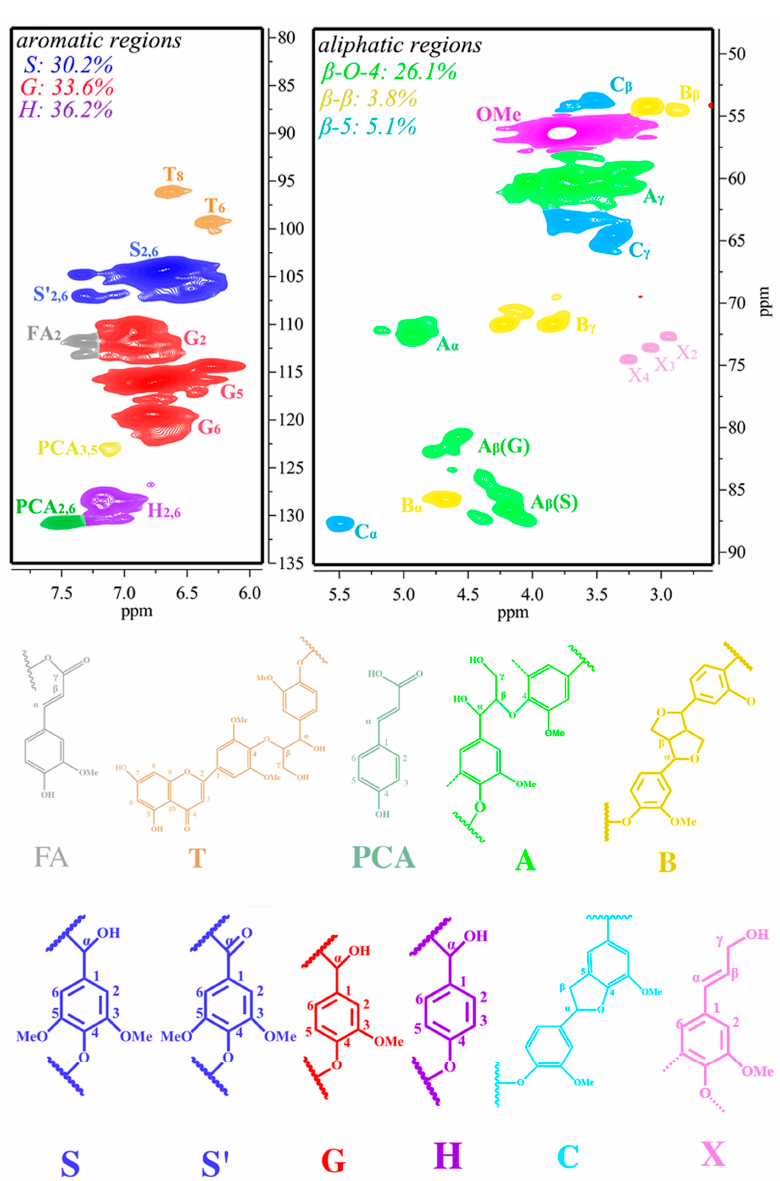
Figure 1. The two-dimensional heteronuclear single quantum coherence nuclear magnetic resonance (2D-HSQC NMR) spectra of the bulrush lignin